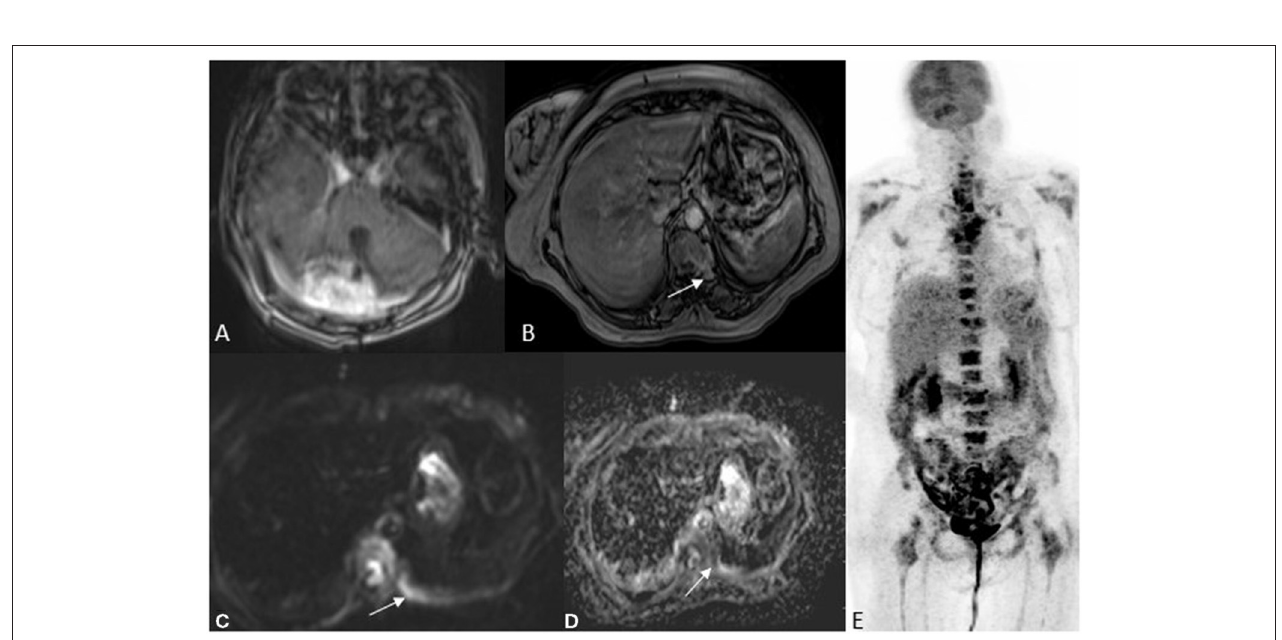
FIGURE 3 | A 52 year old female with imbalance, MRI FDG PET axial brain images T1 post-contrast (A) image showed an enhancing lesion in the right cerebellum. Whole-body MRI with fast sequences at axial hepatic sections (B) VIBE fat sat post-contrast (C) DWI b800 (D) ADC and NAC PET (E) showing an area of metastases to the vertebral body as an area of restricted diffusion and post-contrast enhancement. HPE was suggestive of Pilocytic astrocytoma with metastasis.